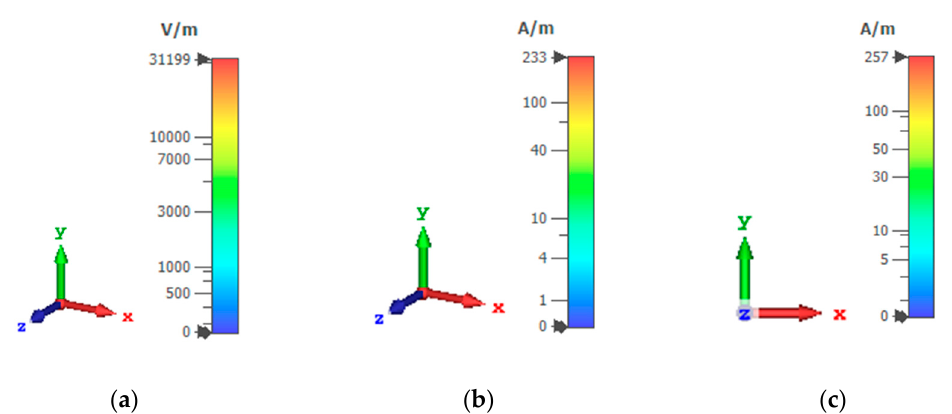
Figure 10. ( a ) Electric field, ( b ) magnetic field, and ( c ) surface current density of FR-4 substrate at 1.95 GHz, 3.49 GHz, 4.155 GHz, and 3.1 GHz. For Roger4450B, the electric field, magnetic field, and surface current are demon- strated in Figure 8 at 2.05 GHz, 3.735 GHz, and 4.4 GHz. In Figure 11a–c, we can see that